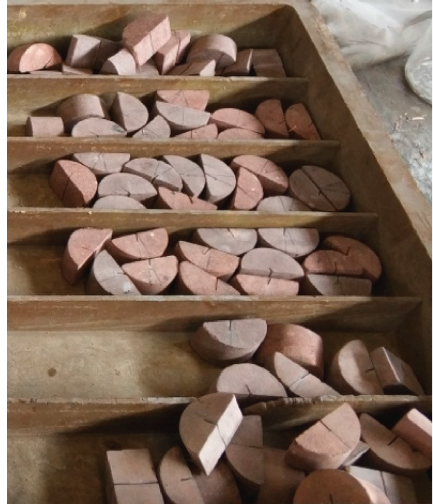
Figure 2: The SCB specimens.